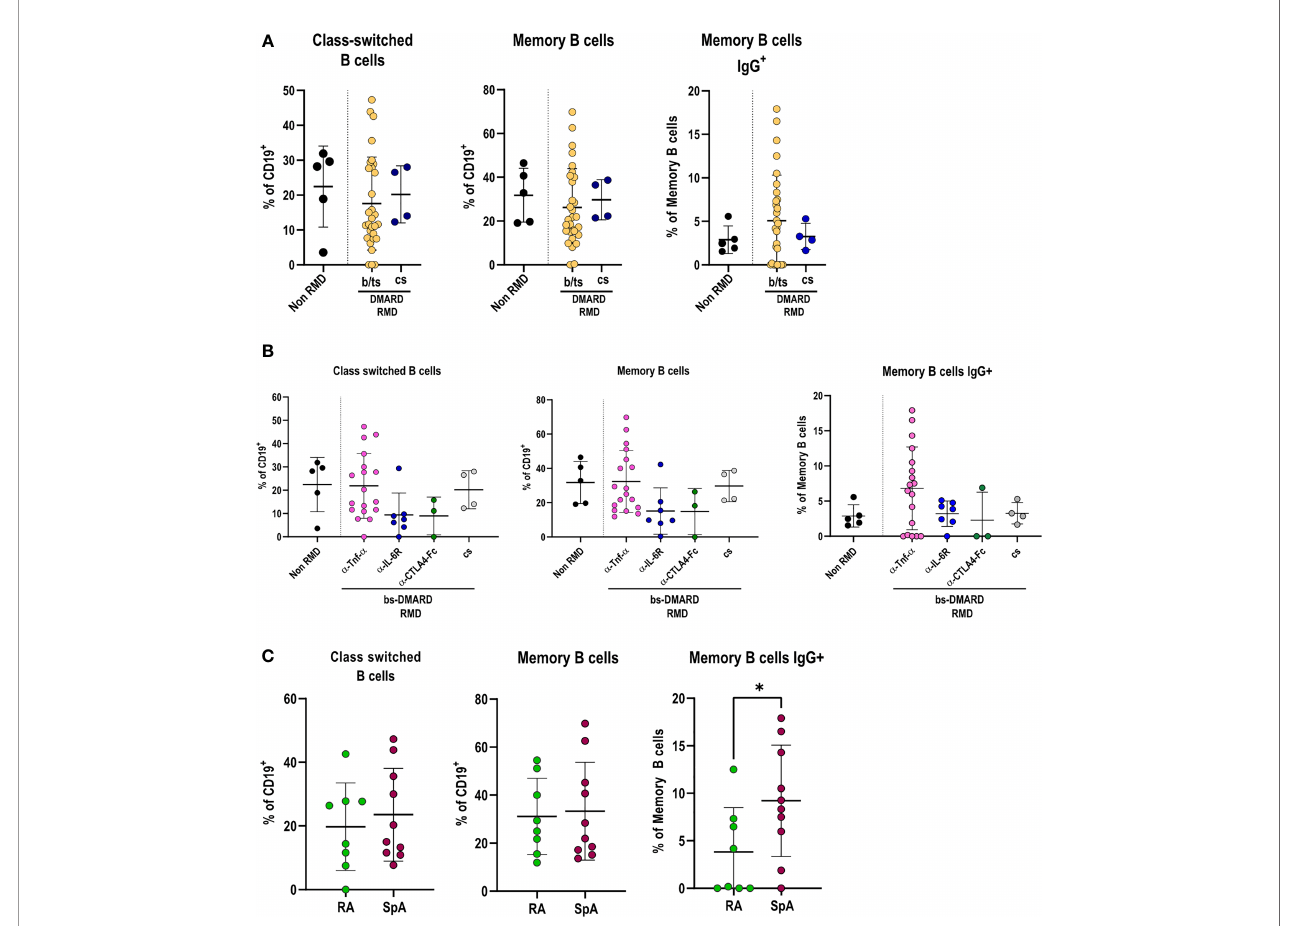
FIGURE 4 | Speci fi c DMARD treatments drive alterations in effector B-cell populations in serologically positive RMD patients. (A) Relative frequencies of class-switched, memory, and memory IgG + cells in peripheral blood of non-RMD patients ( N = 5) and RMD patients treated with b/ts- ( N = 30) or cs-DMARDs ( N = 4). (B) Relative frequencies of class-switched, memory, and memory IgG + cells in peripheral blood of RMD patients undergoing different b-DMARD ( a -TNF- a , N = 18; a -IL-6R, N = 7; CTLA4-Ig, N = 3) or cs-DMARD treatments ( N = 4), and non-RMD patients ( N = 5). (C) Relative frequencies of class-switched, memory, and memory IgG + cells in a - TNF- a -treated patients sorted according to disease (RA, N = 8; SpA, N = 10). Graphs show individual values, means, and SD. Statistical signi fi cance was determined using two-tailed Mann – Whitney test for unpaired data and Kruskal – Wallis tests to compare unpaired samples between multiple study groups. * p <